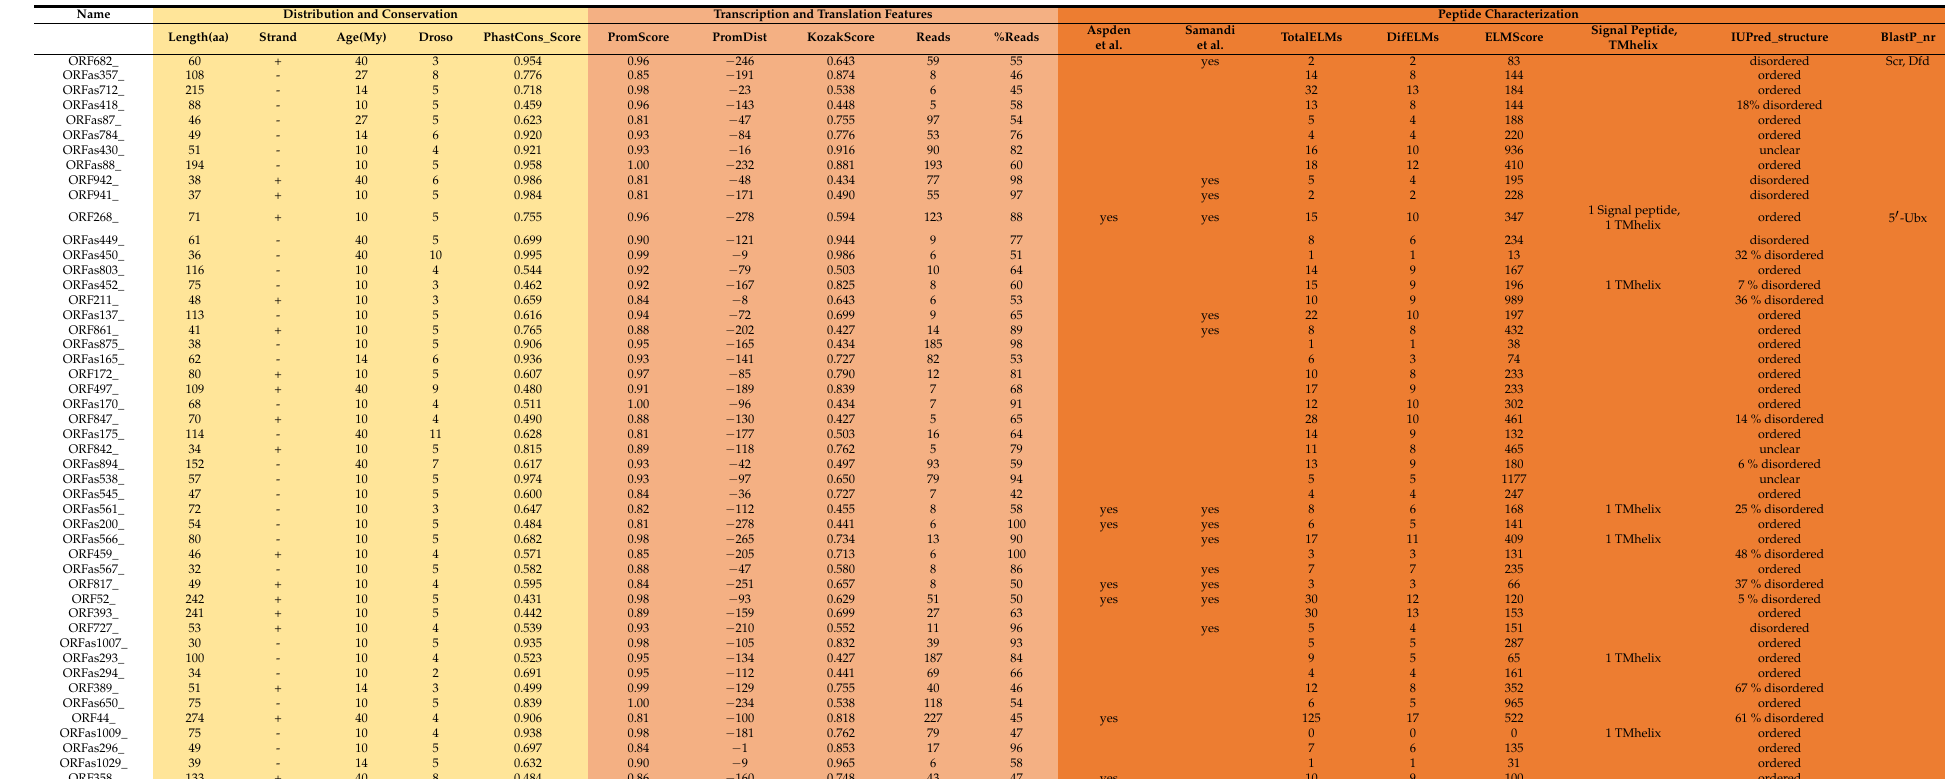
Table 1. List of the 48 selected altORFs following the different filtering steps based on conservation, transcription, and translational marks